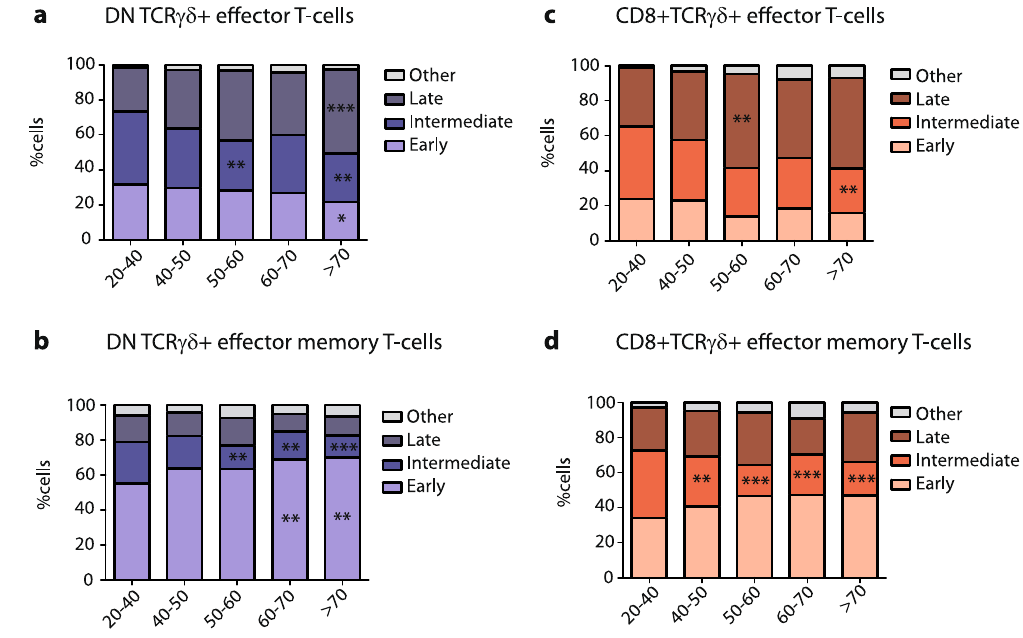
Figure 4. DN and CD8 + TCR γδ+ effector and effector memory differentiation stage distributions during ageing. ( a ) Relative differentiated subset distributions of percentages of DN and ( c ) CD8 + effector and ( b ) DN and ( d ) CD8 + effector memory TCR γδ+ T-cells depicted in stacked bar plots. Significance was tested by a Kruskal-Wallis test, and followed by a post-Dunn’s test for correction for multiple testing. Data of different age groups was compared with the control age group. Significance for the Dunn’s test is indicated in the plots: